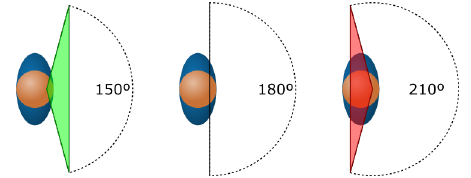
Figure 1. Example illustrating different projections of fields of view. The image on the left shows the example of an horizontal angle of 150 ◦ . The image on the center shows an example with an angle of 180 ◦ . In this case, the planes near and far coincide, i.e., the frustum volume is zero. The image on the right shows an example with an angle of 210 ◦ . The problem in that case is that the far plane is behind the agent’s head causing undesired errors of